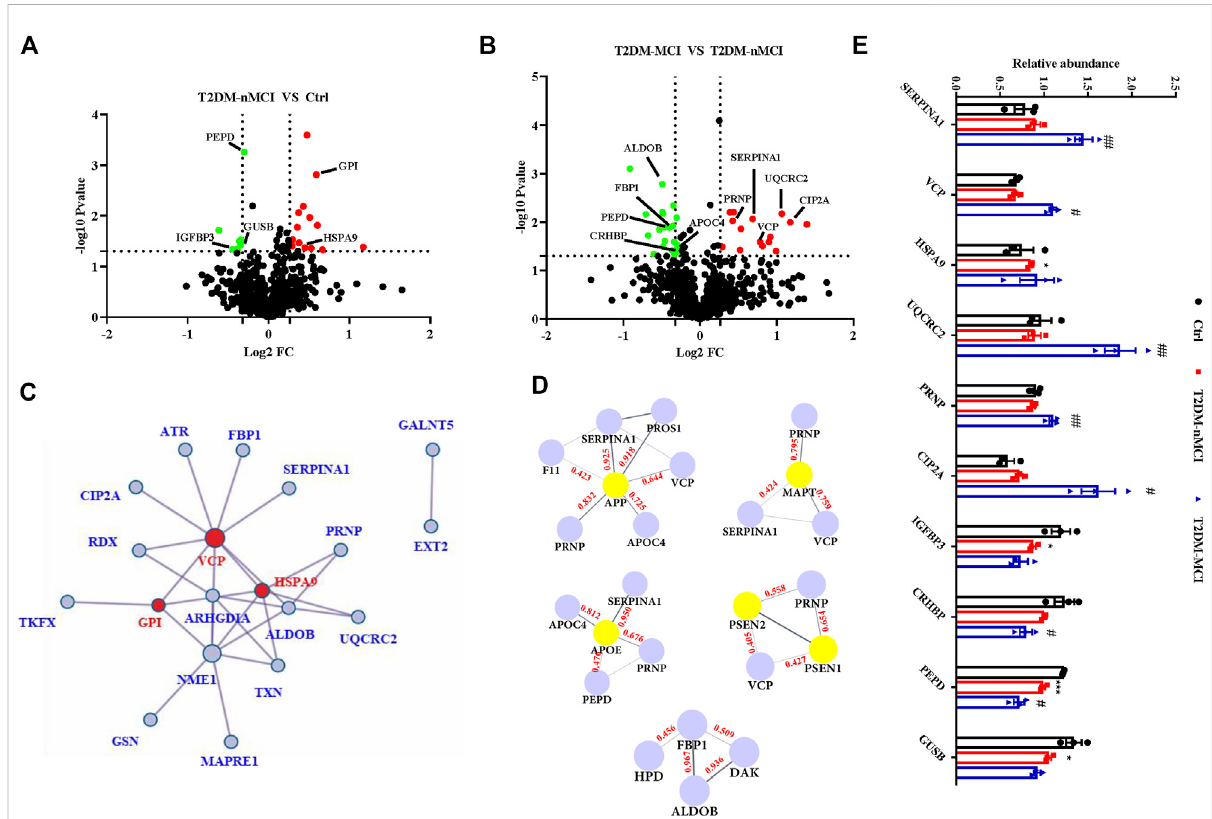
FIGURE 3 Protein – protein interaction network of DEPs in T2DM-MCI patients analyzed by a comprehensive analysis. (A,B) Volcano plot for the identi fi ed plasma proteins in T2DM-nMCI vs. Ctrl and T2DM-MCI vs. T2DM patients. Red and green dots indicate signi fi cantly up-regulated and down- regulated proteins, respectively. (C) All the differentially expressed proteins (DEPs) were visualized and mapped using Cytoscape 3.7.1. STRING analyses of hippocampal DEPs. Red dots indicate key regulatory nodes. (D) PPI modules associated with AD high-risk genes. Based on